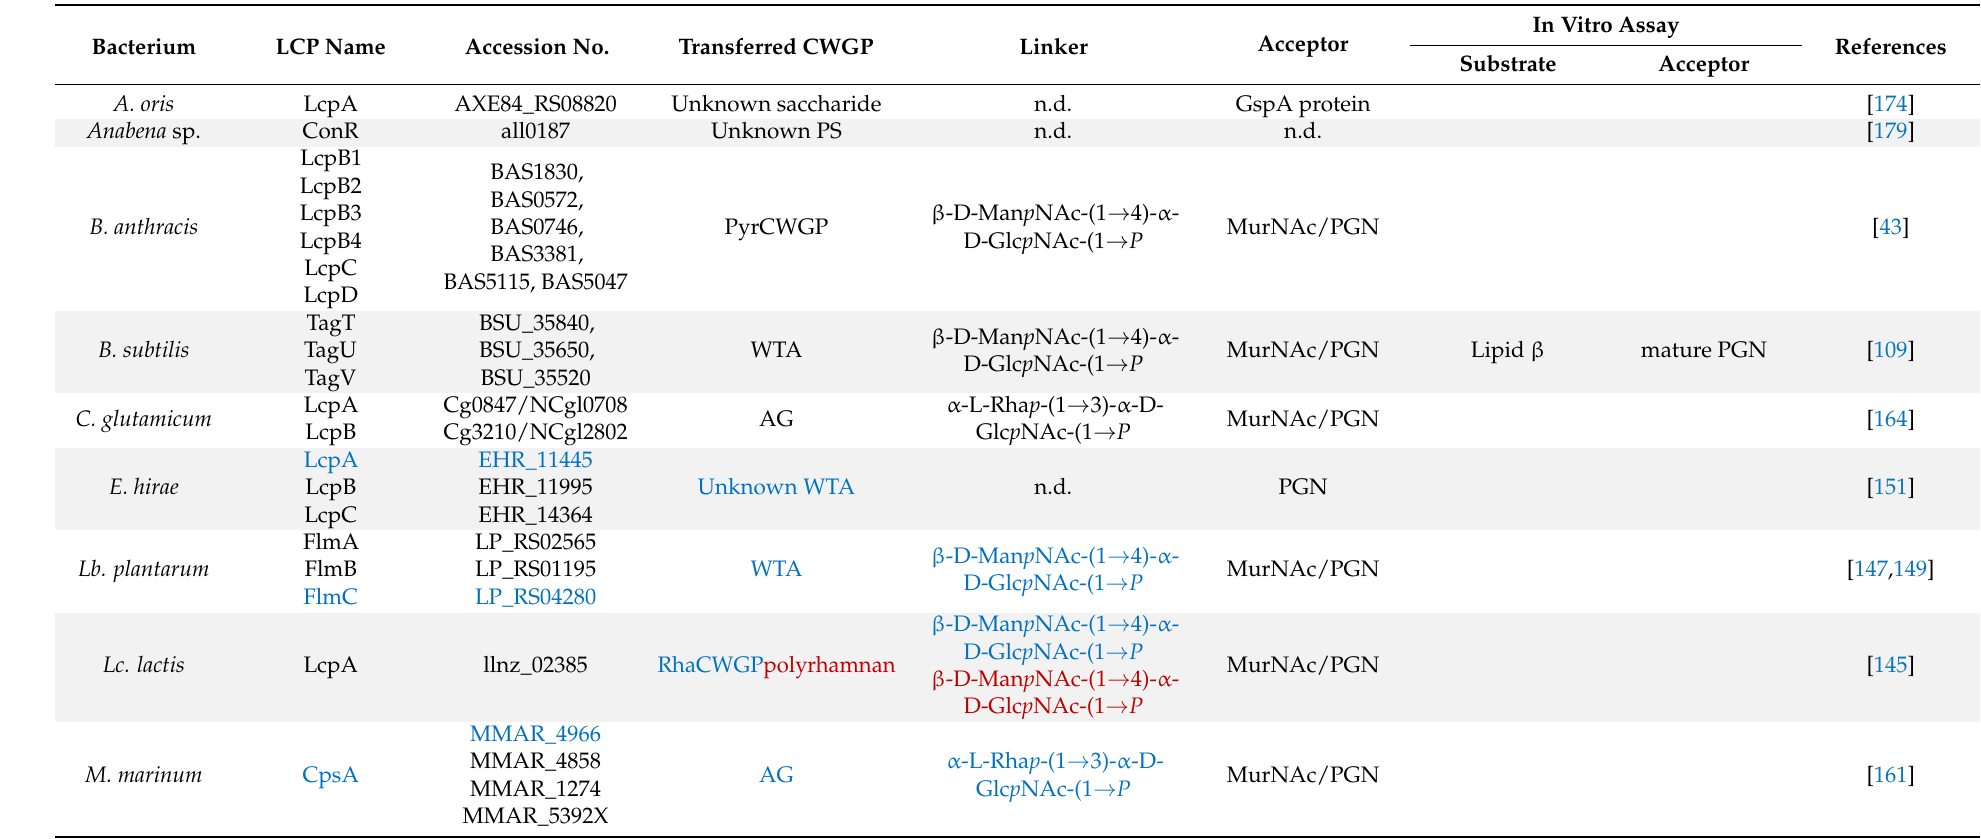
Table 1. Summary of LCP proteins discussed in this review 1